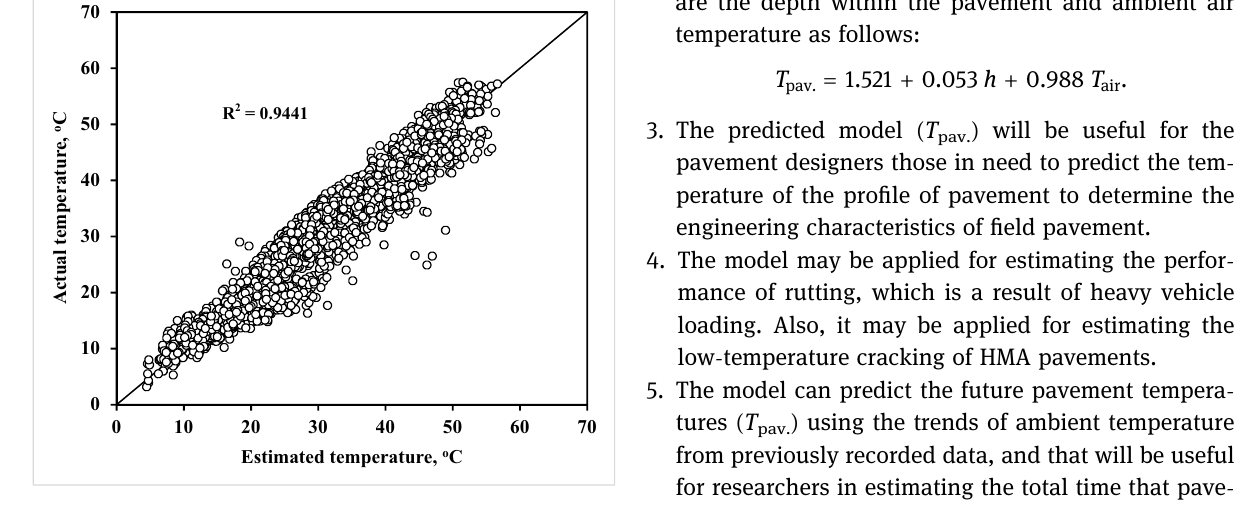
Figure 5: Actual versus estimated pavement temperature ( T pav. )